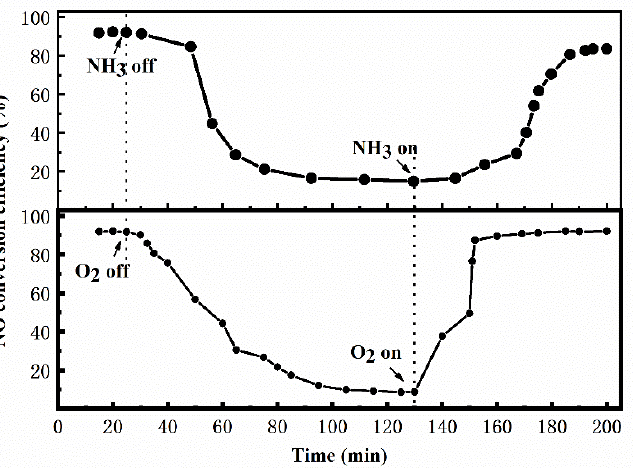
Figure 1. Transient response at 150 ◦ C with NH 3 and O 2 on–off, showing the de-nitration on the novel Mn10Ce41/NG catalyst.